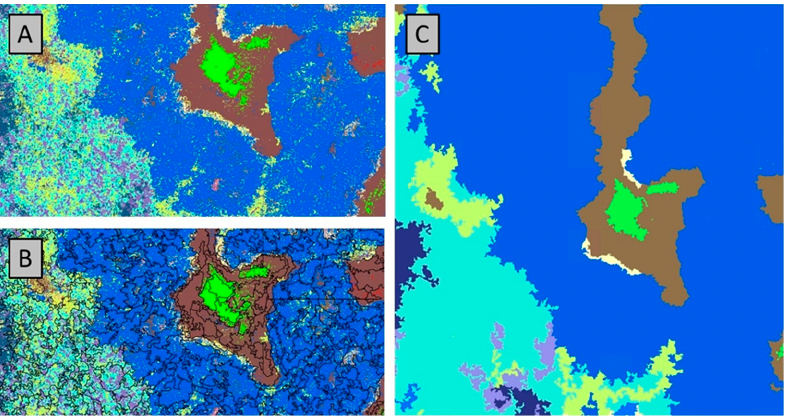
Figure 10. Majority filter applied to a classified image. ( A ) Classified image before filtering. ( B ) Segmented objects used to apply the majority filter. ( C ) Filtered image produced by labeling each object by its majority class.